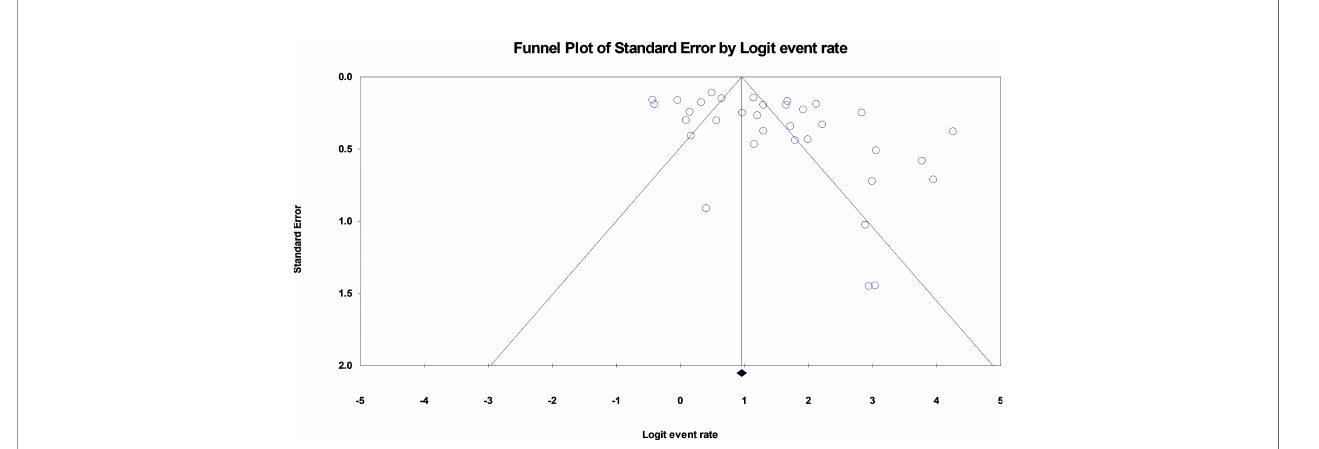
FIGURE 2 | funnel plot of standard error by logit event rate. The Egger ’ s test was used, SE 3.7 (95% CI, 1.03, 6.37), t-valu82, df 32, P = 0.008 indicating a strong publication bias across the